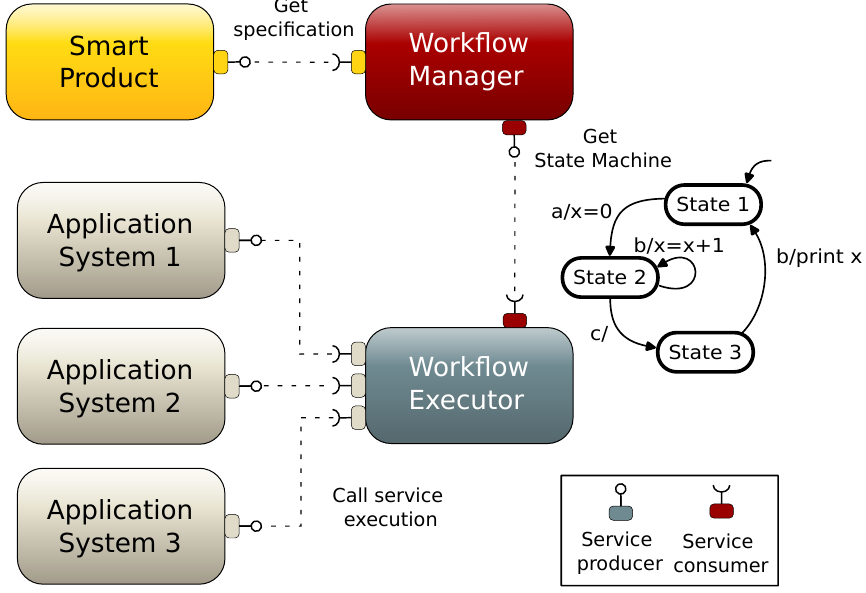
Figure 4. Workflow Manager and Executor service interactions